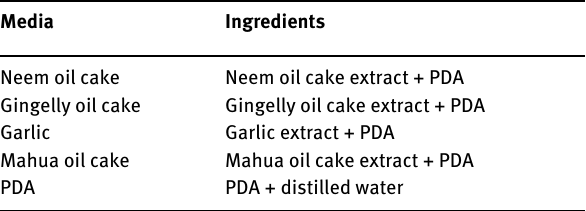
Table 1: Media preparation to evaluate the sporulation of T.